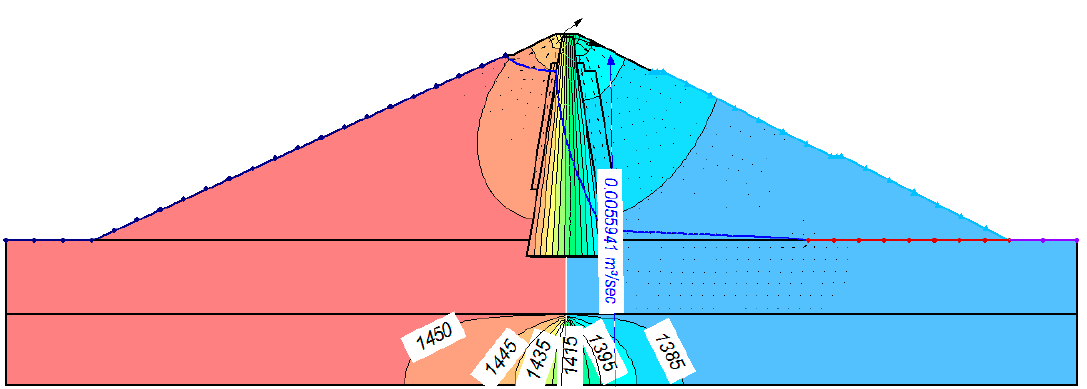
Figure 17. Flow and equipotential lines of the dam with the 90 m drainage system.